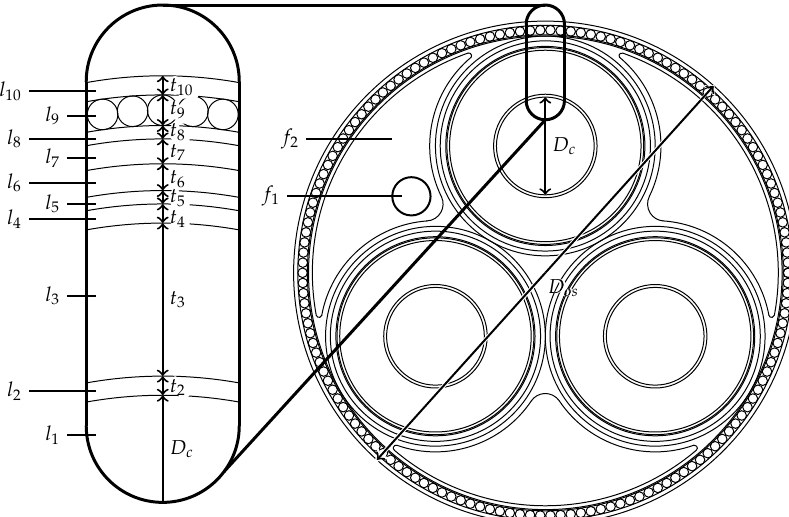
Figure 2. General structure of a three-core cross-linked polyethene (XLPE) separate lead (SL)-type submarine cable with all layers included; diameters D , thickness t and layers l are illustrated and